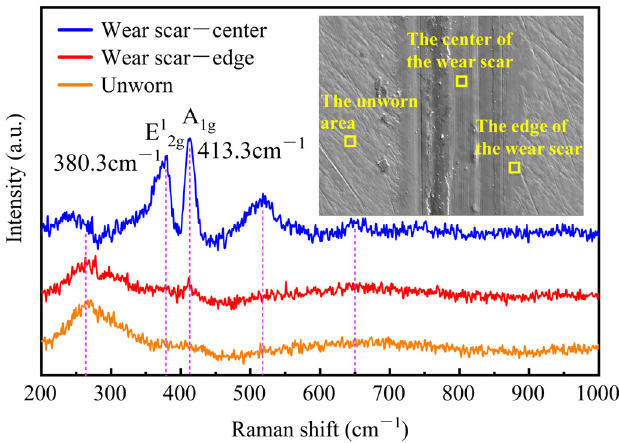
Figure 13. 2D cross-sectional curves of the wear scars.